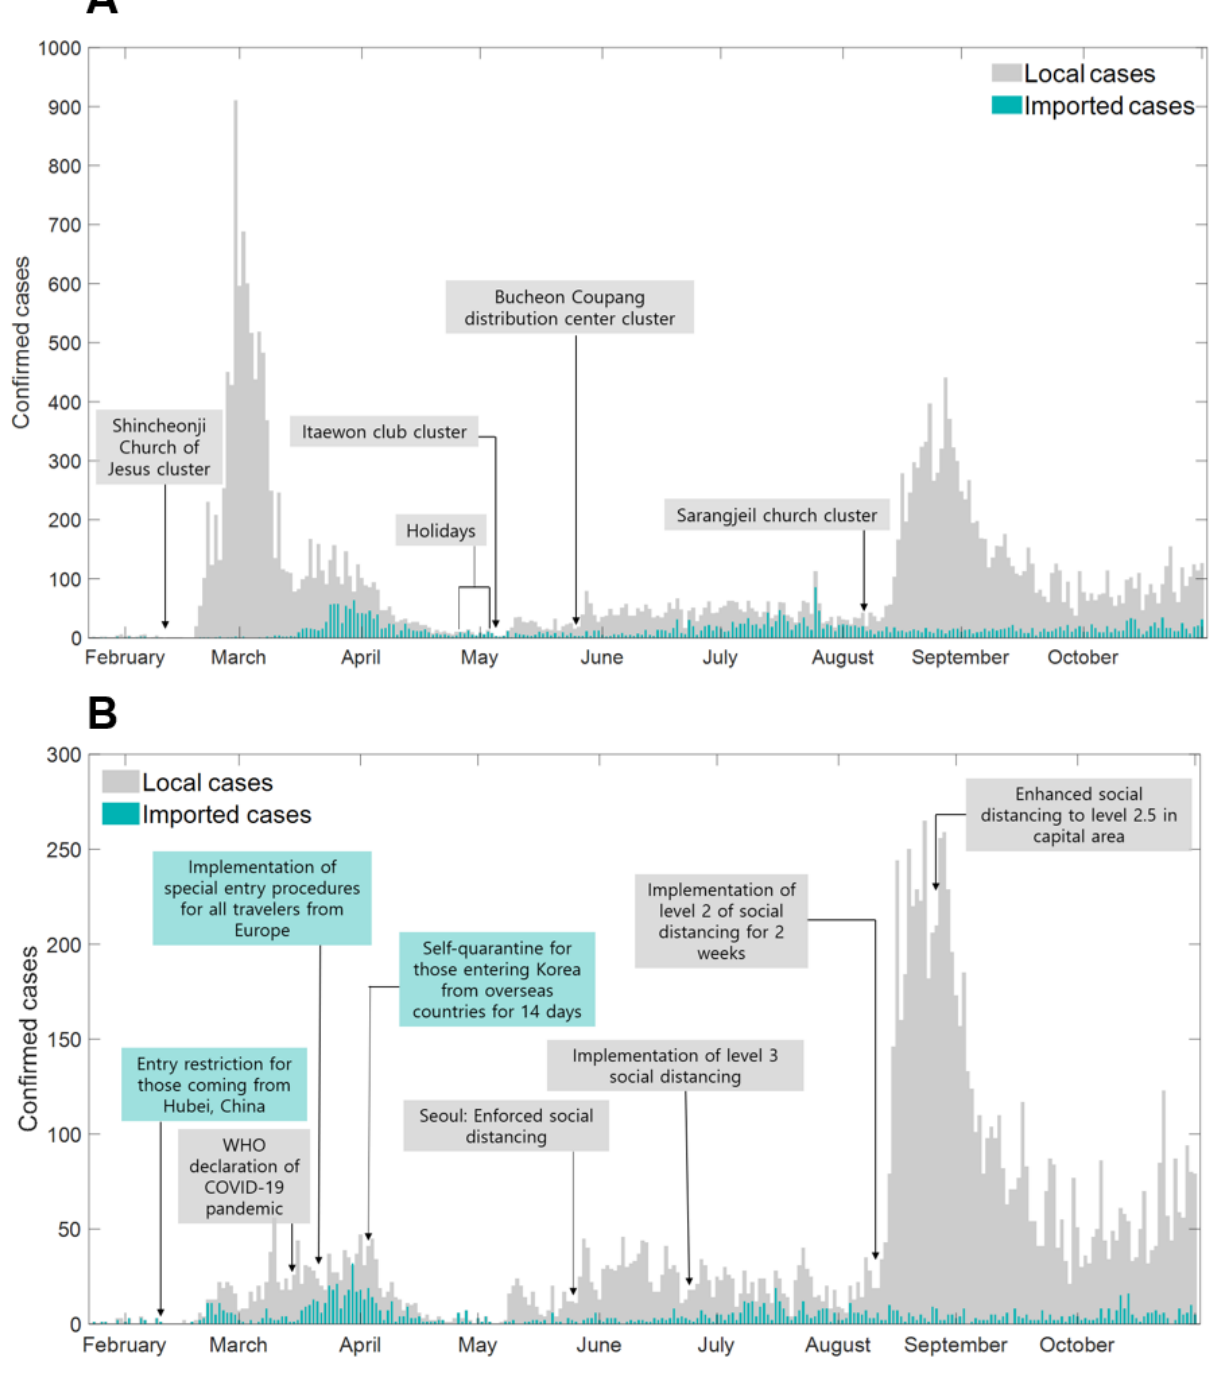
Figure 1. Epidemic curve of imported cases and local cases in South Korea. (A) Daily number of imported and local cases of COVID-19 in South Korea. (B) Daily number of imported and local cases in Seoul and Gyeonggi. Gray bars and green bars represent local cases and imported cases, respectively. WHO: World Health